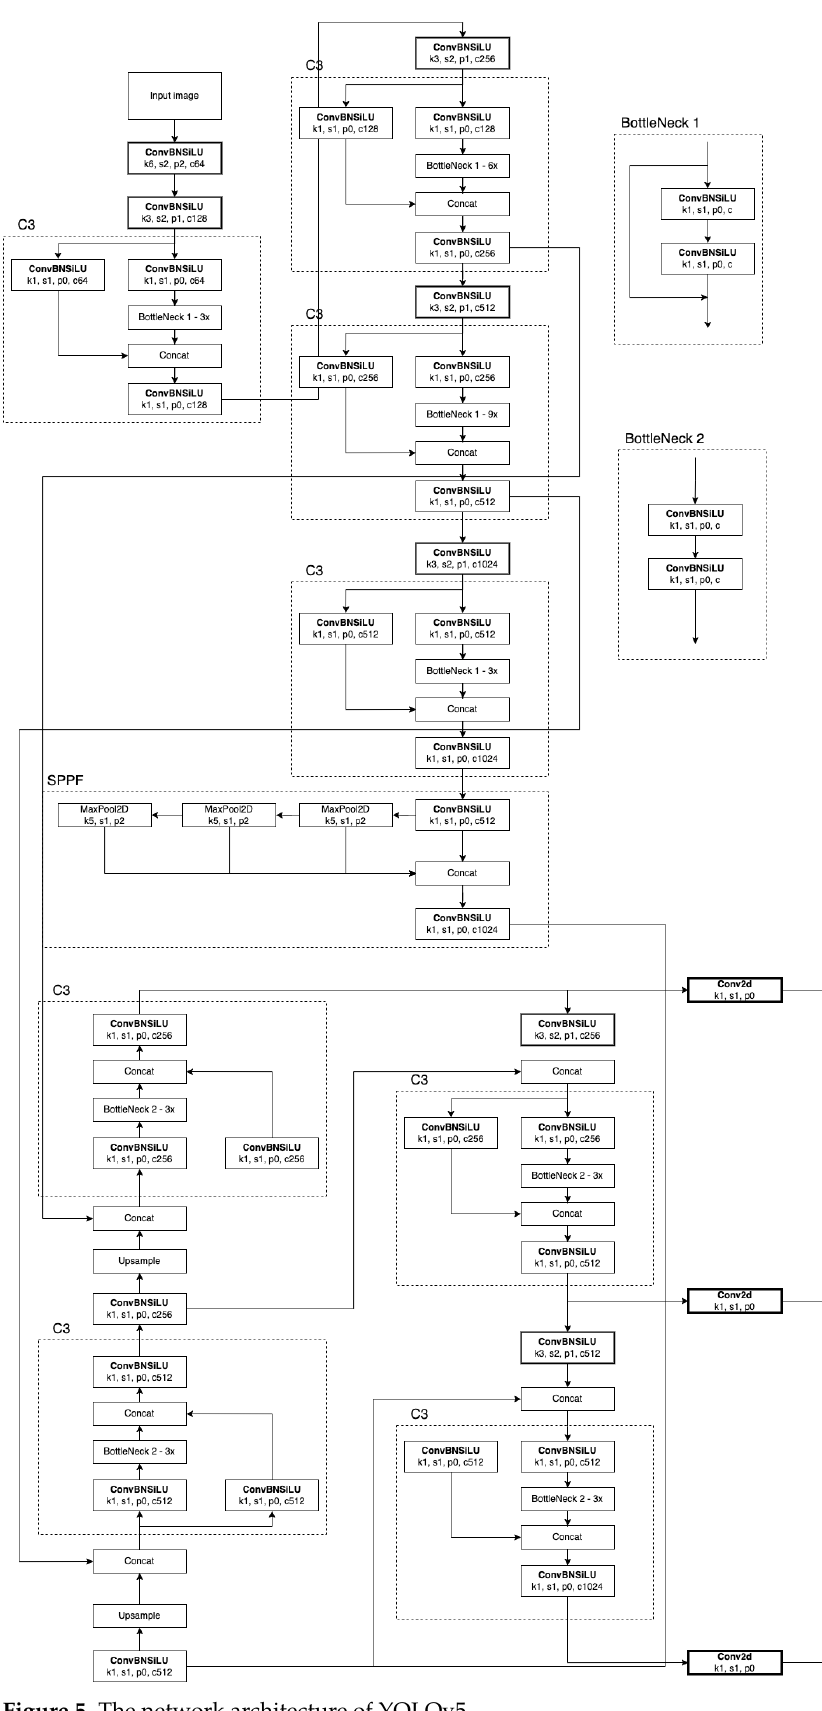
Figure 5. The network architecture of